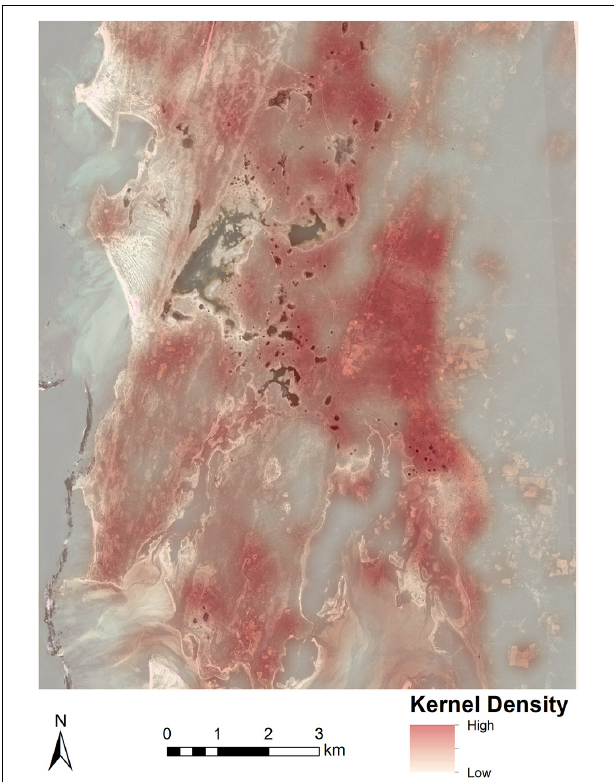
FIGURE 6 | Density of anthropogenic modifications within the study region identified by the machine learning algorithm. Imagery © 2020 Planet Labs.